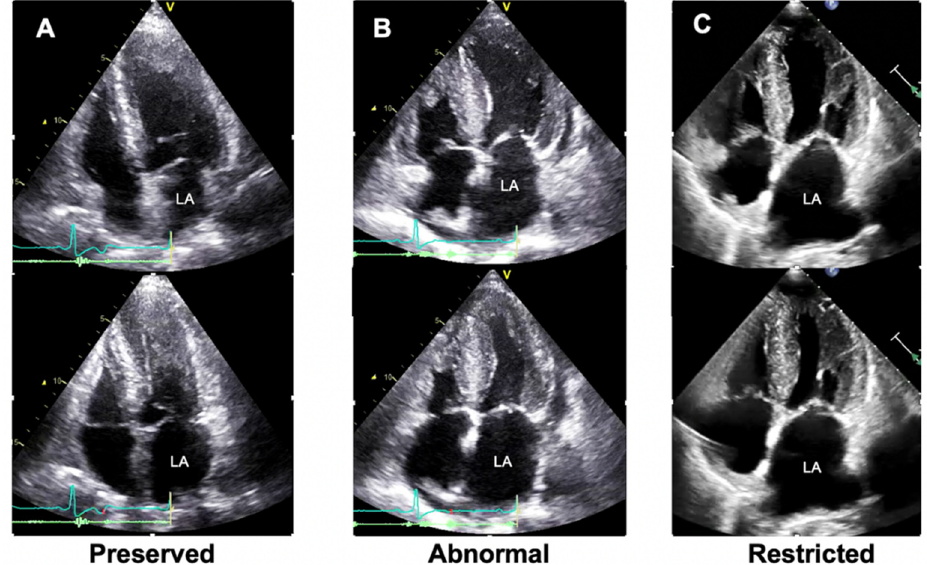
Figure 4. Visual assessment (grading) of left atrial reservoir function. ( A ) A case of hypertrophic cardiomyopathy. ( B , C ) Two cases of cardiac amyloidosis. The upper panel in each case is a frame when the LA size is minimized, while the lower panel is a frame when the LA size is maximized. In a patient with hypertrophic cardiomyopathy, the LA dilatation grade (Inoue grade) was preserved ( A ). In contrast, two patients with cardiac amyloidosis showed abnormal ( B ) and restricted ( C ) LA dilatation, indicating LA stiffening. LA, left